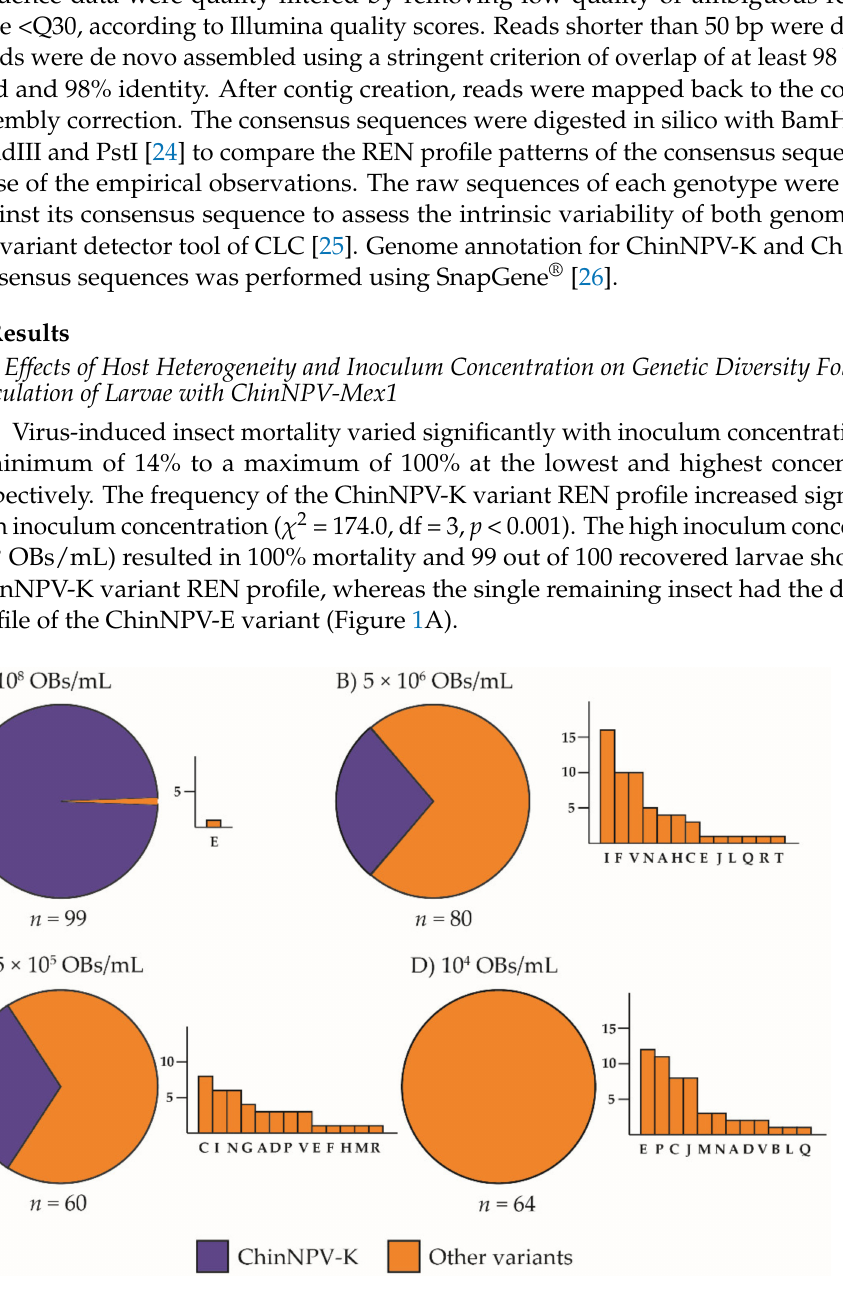
Figure 1. Prevalence of ChinNPV variants by dominant REN profile in Chysodeixis includens fifth instar larvae inoculated with ChinNPV-Mex1 OBs at concentrations of ( A ) 10 8 , ( B ) 5 × 10 6 , ( C ) 5 × 10 5 , ( D ) 10 4 OBs/mL. Circular charts represent the proportions of dominant REN profiles similar or different to that of ChinNPV-K OBs recovered from virus-killed larvae (indicated as ChinNPV-K and Other variants, respectively). A bar chart is depicted next to each circular chart, specifying which REN profiles were observed among the other variants. The y -axis indicates the number of insects that showed a particular dominant REN profile in the progeny OBs and the x -axis indicates each of the REN profiles observed in descending frequency; n indicates the number of insects